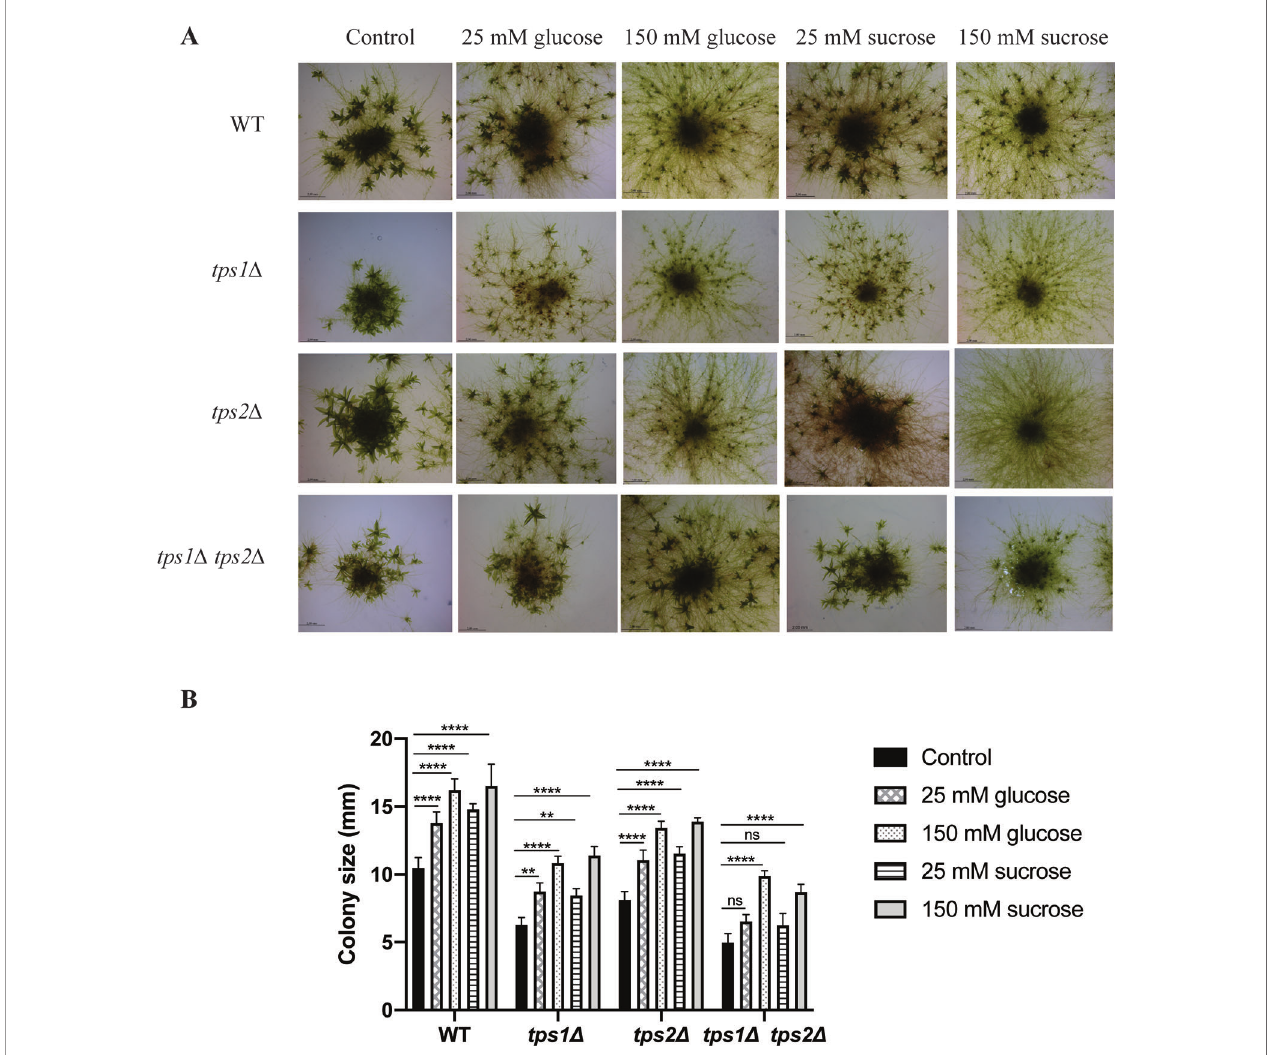
FIGURE 10 | Effect of sugars on growth of wild-type (WT) and transgenic plants. (A) Morphology of wild-type (WT) and knockout plants grown on plain BCDAT medium or BCDAT medium supplemented with different sugars (glucose and sucrose). Bars represent 2 mm. (B) Measurement of colony size of WT and knockout plants. Data represent mean ± SD of three individuals of protonema colonies. Statistical analysis with two-way ANOVA, **p ≤ 0.01, ****p ≤ 0.0001, ns, no signi fi cant